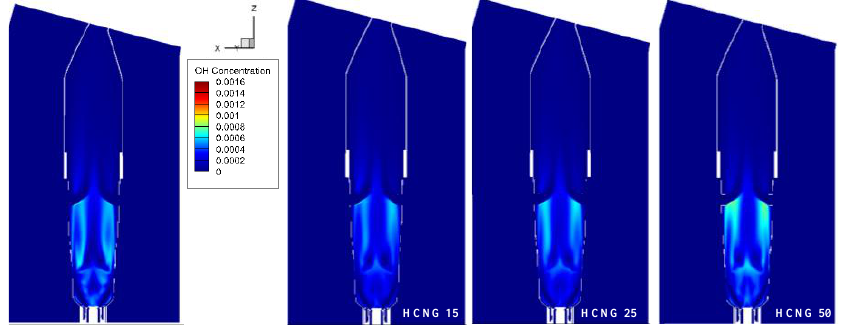
Figure 18. Contours of OH concentration in slice 1.